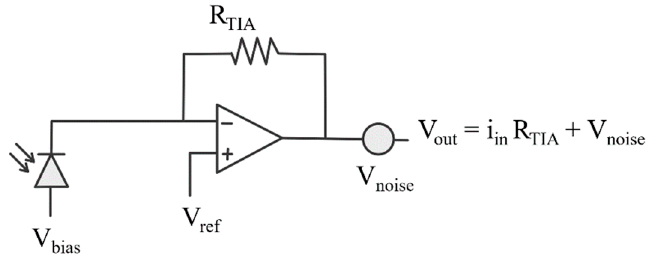
Figure 6. Photocurrent to voltage conversion stage including noise due to feedback resistance.